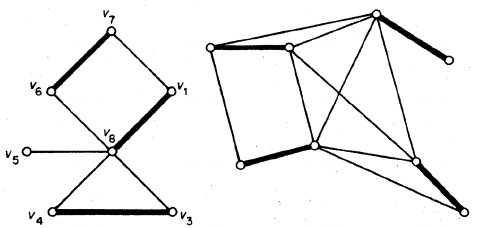
Figure 3: To the left - a maximum matching ( M = { ( v 4 , v 3 ) , ( v 8 , v 1 ) , ( v 6 , v 7 ) } ). To the right - a perfect matching.